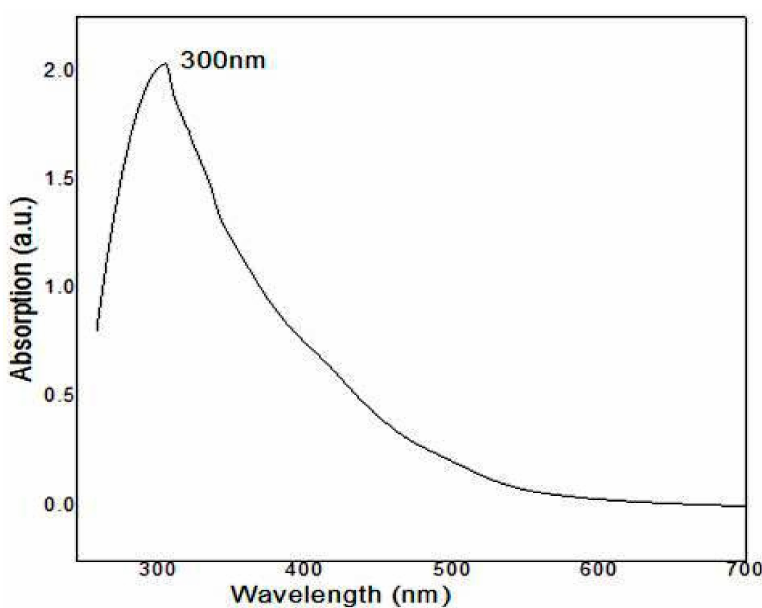
Figure 3. UV-visible spectroscopy of zinc nanoparticles synthesized using Eucalyptus globules leaf extract showing absorption peak at 300 nm.